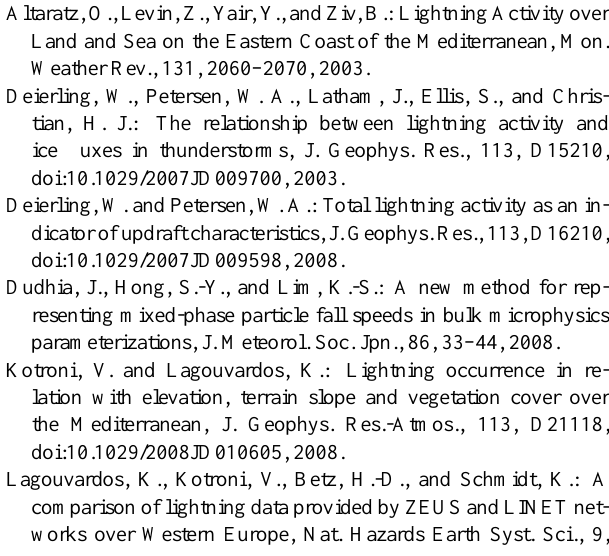
timing and location of predicted lightning producing